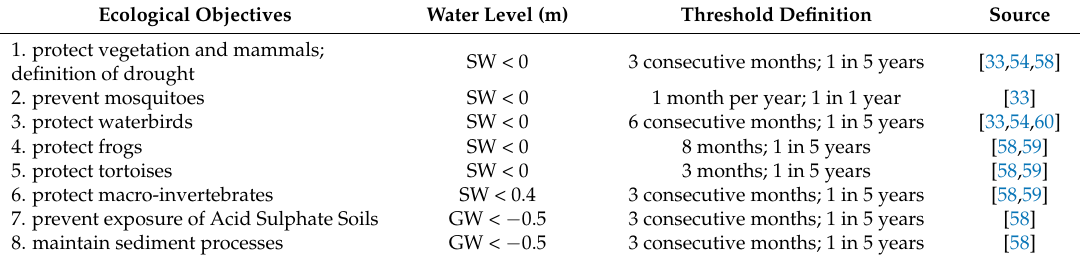
Table 1. Threshold values for the ecological objectives to determine ATPs for surface water (SW) and groundwater (GW) levels in (non)-consecutive months derived from the state water policy. 21.6 m AHD (mean water level in Australian Height Datum in meters) is the height of the lake bed, which we here denote as zero; all thresholds are defined as water depth with respect to the lake